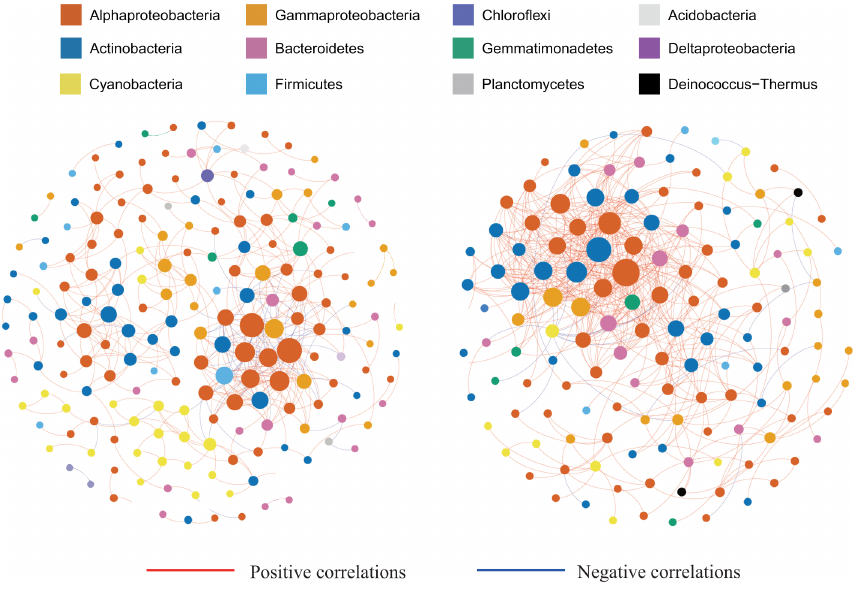
Figure 6. Bacterial co-occurrence networks for the surface and subsurface layer communities. Each node represents a bacterial amplicon sequence variant (ASV). The solid red lines represent positive correlations, and the solid blue lines represent negative correlations. Nodes are colored by taxonomy at the phylum level. The subsurface community networks are more complex with a higher positive-to-total correlation